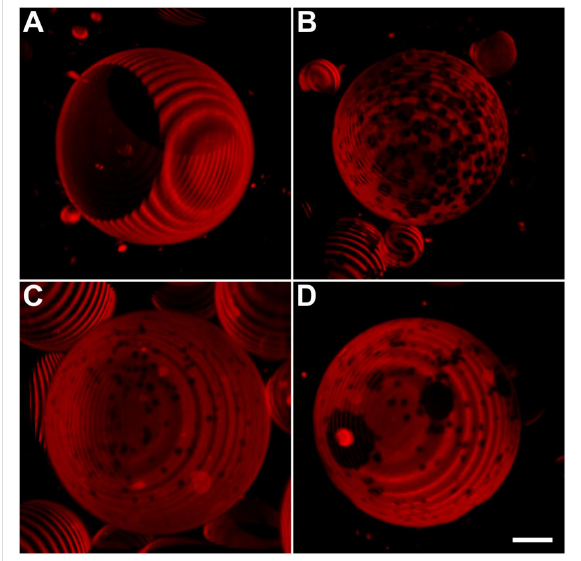
Figure 4: Confocal fluorescence images of GUVs containing DOPC/ PSM/cholesterol (A), DOPC/PSM/24 R -HC (B), DOPC/PSM/24 S -HC (C), or DOPC/PSM/27-HC (D) (molar ratios 1:1:1). The GUV mem- branes were labeled with N-Rh-DOPE (0.5 mol %) that sorts preferen- tially into liquid disordered (ld) domains and z-stacks of the vesicles were recorded as described in the Experimental. Bar corresponds to 10 µm. The ring-like structures of the vesicles are caused by the assembly of the z-stacks having a step-size of 1